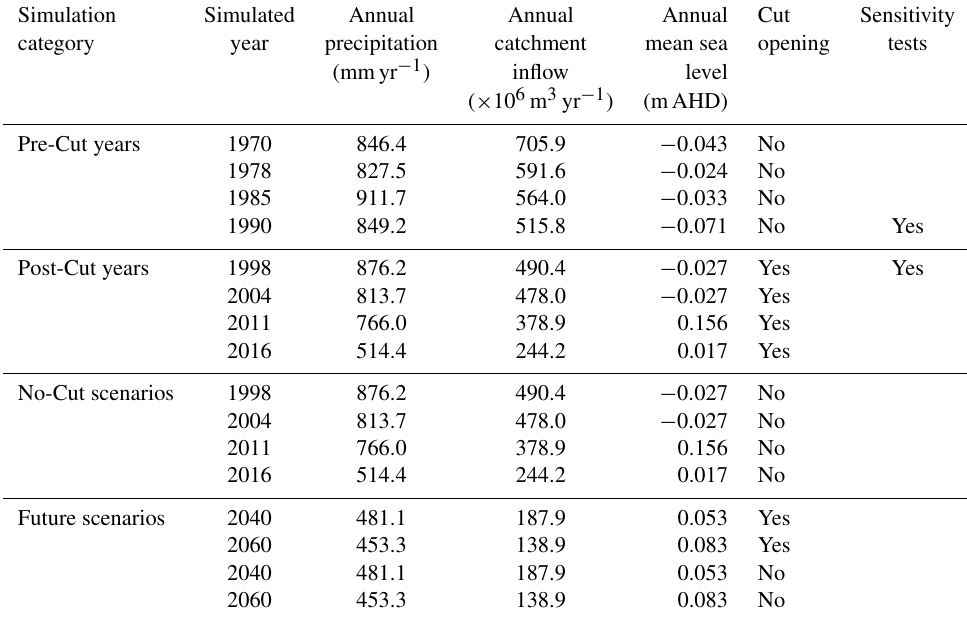
Table 3. Summary of simulated scenarios and their annual precipitation, catchment inflow volumes, mean sea level and Cut-opening infor-